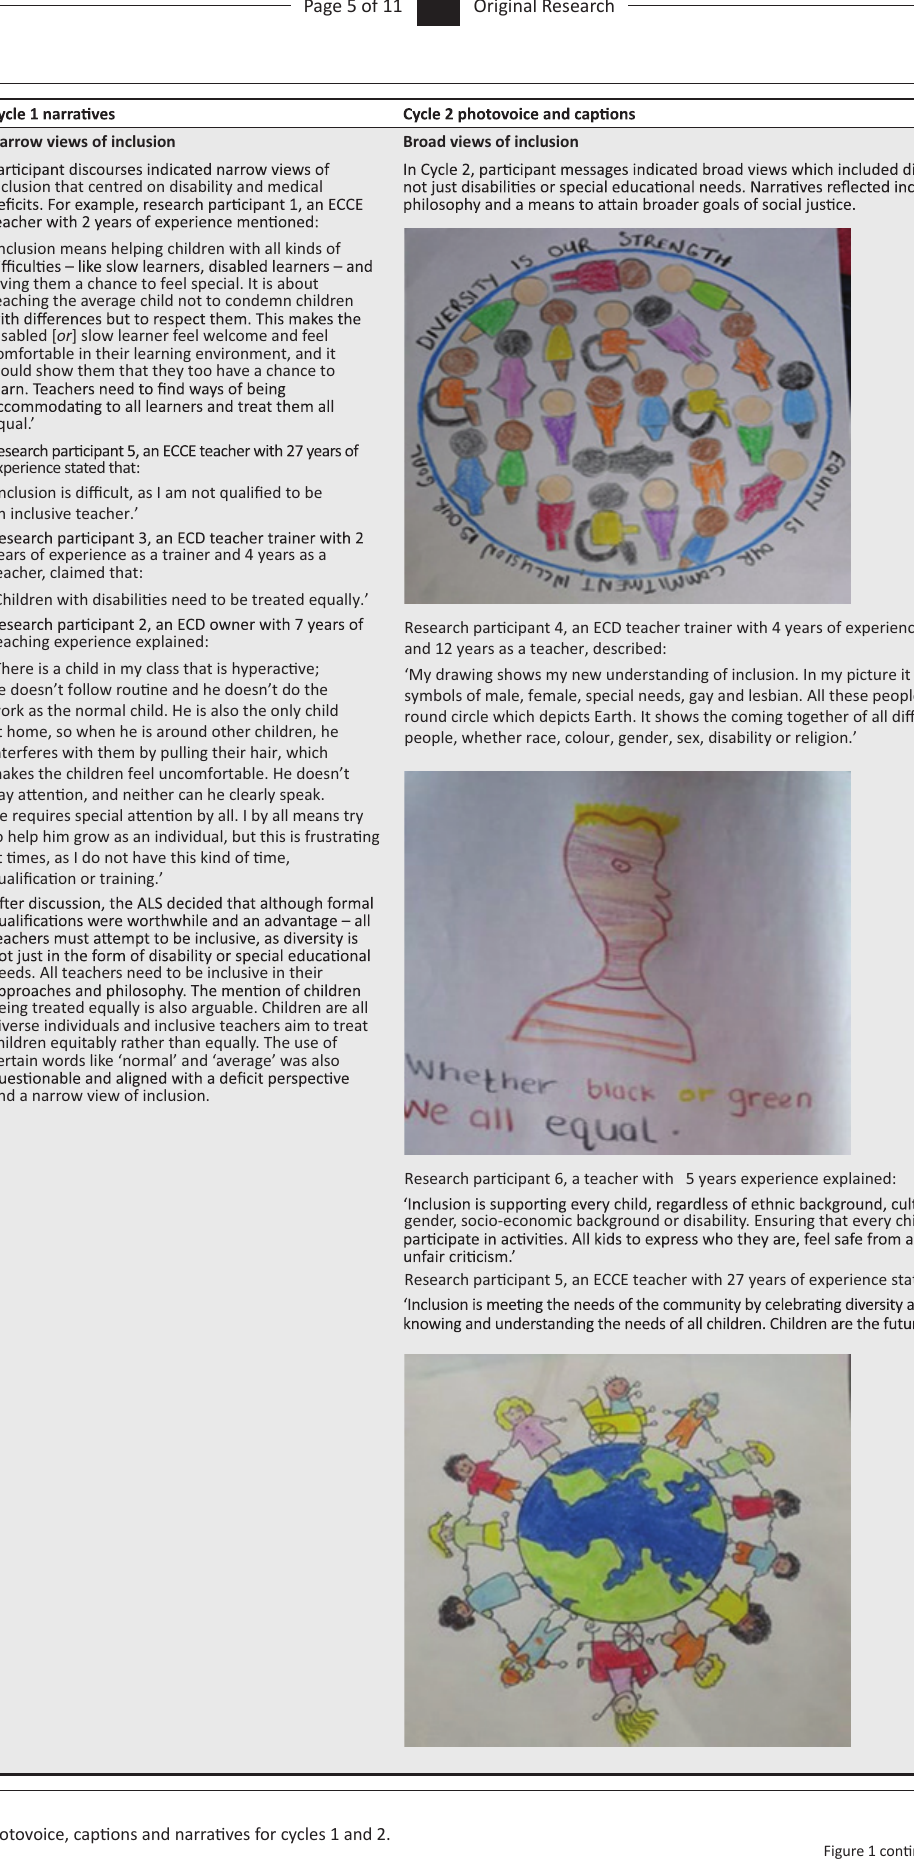
Figure 1 continues on the next page